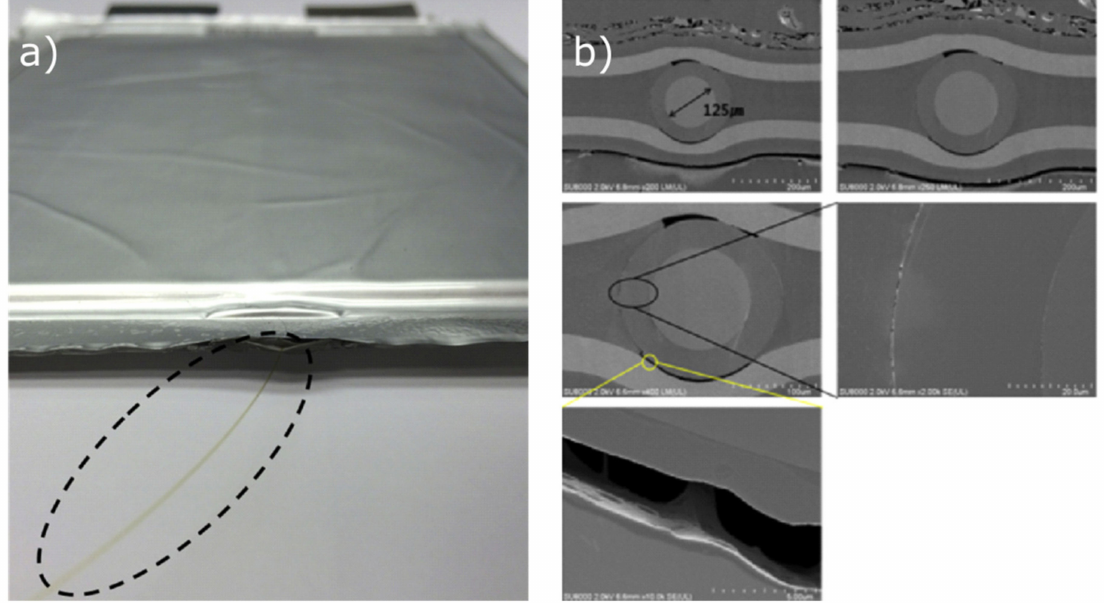
Figure 7. Images captured of a LiB pouch cell with an embedded fibre-optic sensor ( a ) and the cross-section that shows a potential leak around the fibre ( b ) [118]. Reprinted from [118]. Copyright 2017